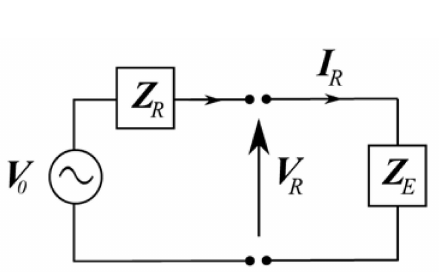
Figure 4. Helmholtz–Thevenin electric circuit for the electroacoustic transducer upon signal reception. (Reproduced from [22], with permission from the Institute of Marine Research,